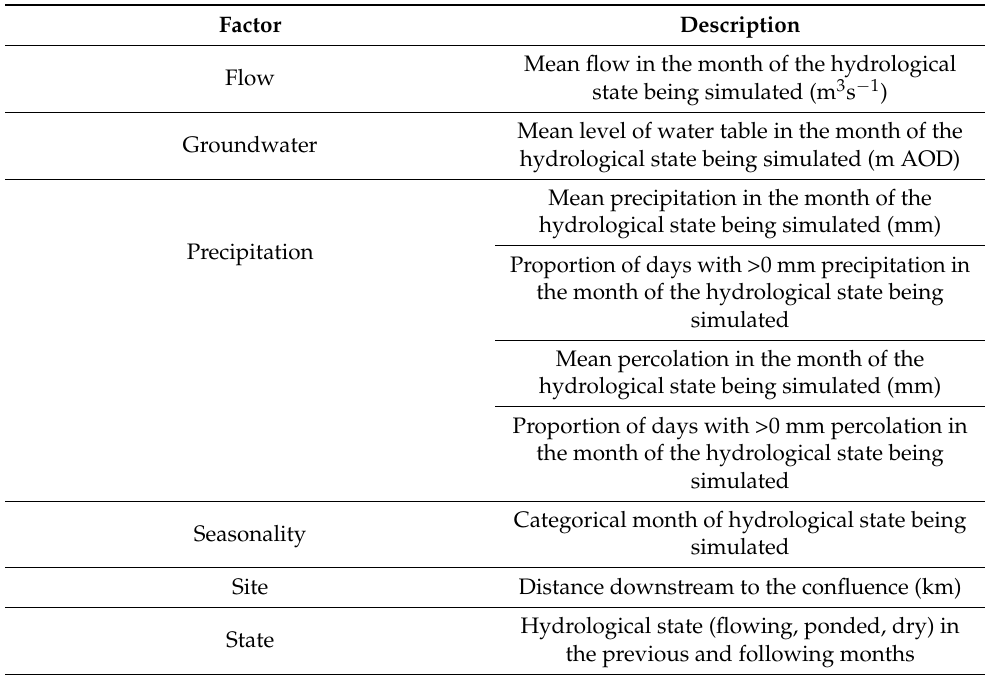
Table 1. Covariates used to simulate hydrological